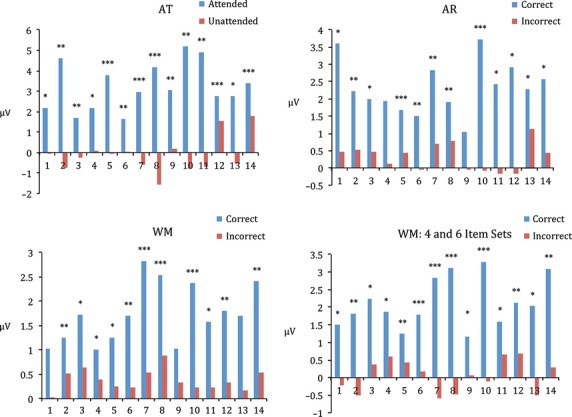
Top left: Mean voltage magnitude within largest CMPT cluster for each participant in AT task. Bottom left: Mean voltage magnitude within largest CMPT cluster for each participant in WM task. Top right: Mean voltage magnitude within largest CMPT cluster for each participant in AR task. Bottom Right: Mean voltage magnitude within largest CMPT cluster for each participant in WM task with eight item sets excluded. ***P < 0.001, **P < 0.01, *P < 0.05.